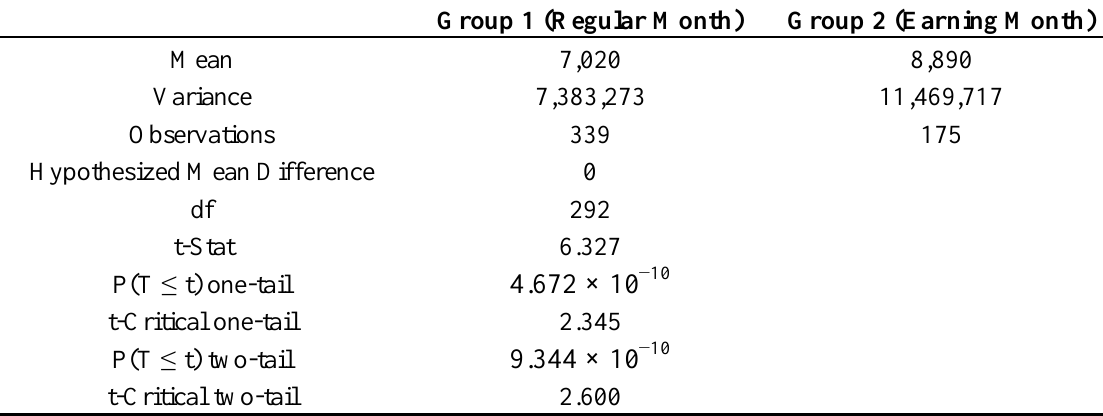
Table 2. T -test on the same mean value for news counts in regular months and earning announcement months, assuming unequal